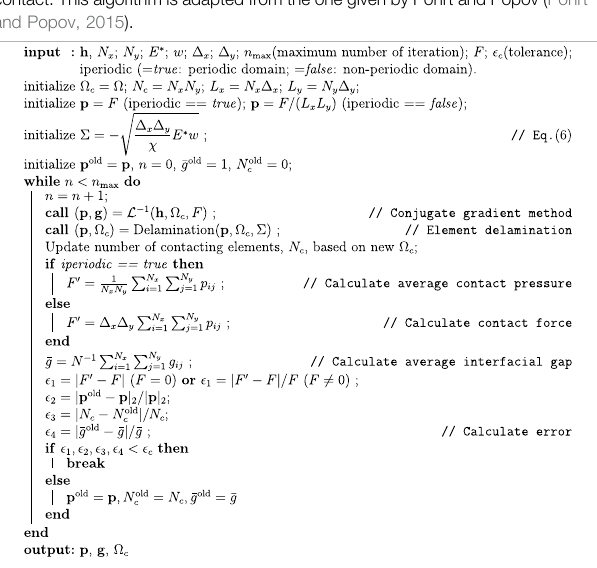
Algorithm 3 | BEM (Pohrt & Popov). The algorithm for boundary element method of linear elastic purely normal contact. This algorithm is adapted from the one given by Pohrt and Popov (Pohrt and Popov, 2015).